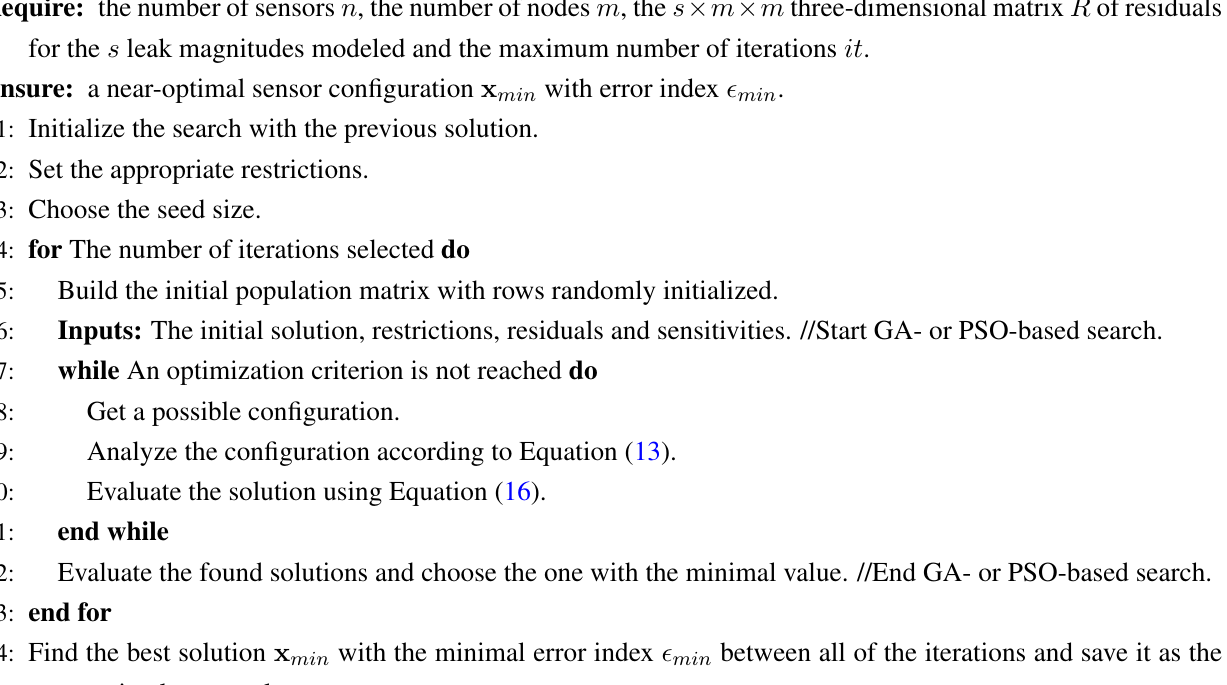
Algorithm 1 Sensor placement based on genetic algorithms or particle swarm